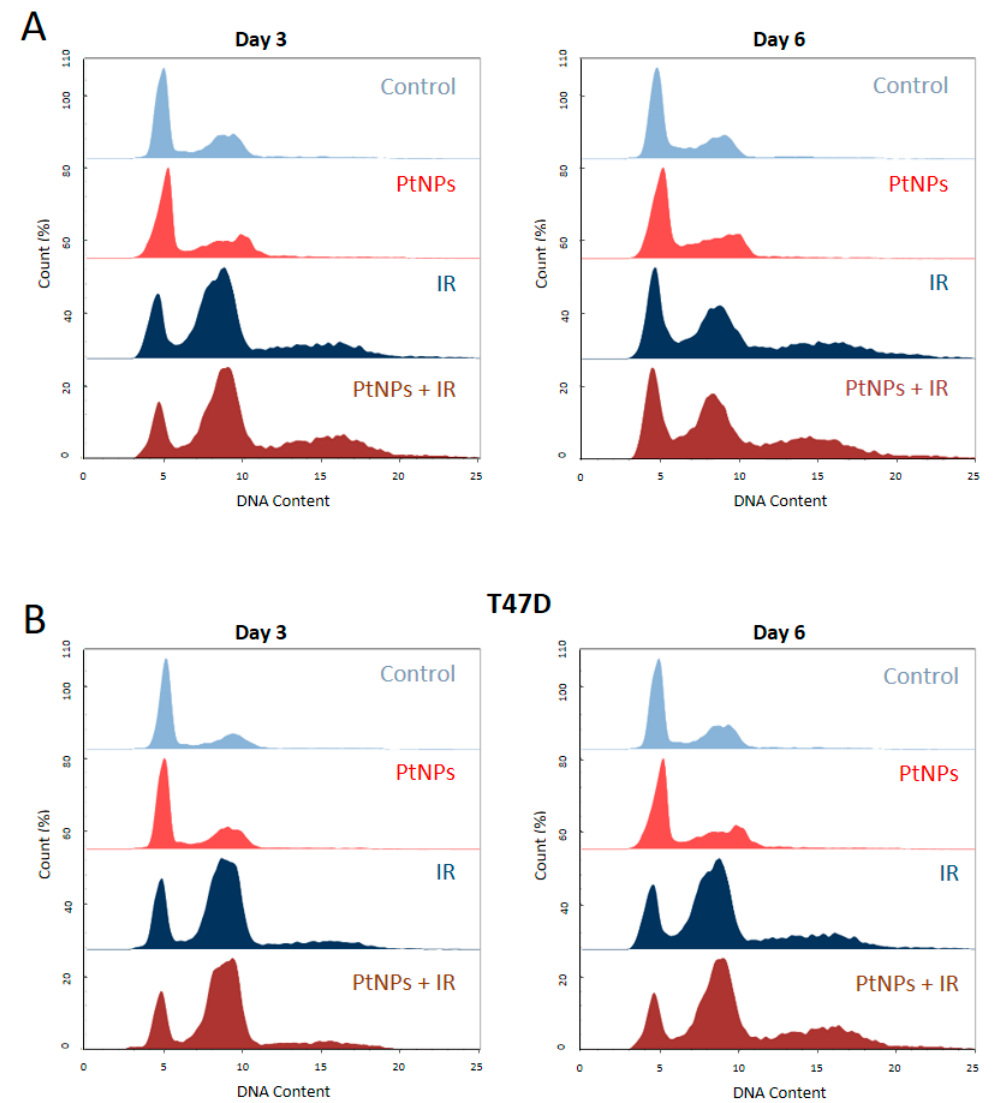
Figure 4. Cell-cycle analysis of 6 Gy-irradiated breast cancer cells pretreated or not with 0.5 mM PtNPs. ( A ) Cell-cycle distribution of the MDA-MB-231 cells exposed to 0.5 mM PtNPs and/or 6 Gy irradiation. Cells were harvested at day 3 ( n = 3) or at day 6 ( n = 3) after the exposure and/or irradiation. ( B ) Cell-cycle distribution of the T47D cells exposed to PtNPs and/or 6 Gy irradiation. Cells were harvested at day 3 ( n = 1) or at day 6 ( n = 2) after the exposure and/or irradiation.